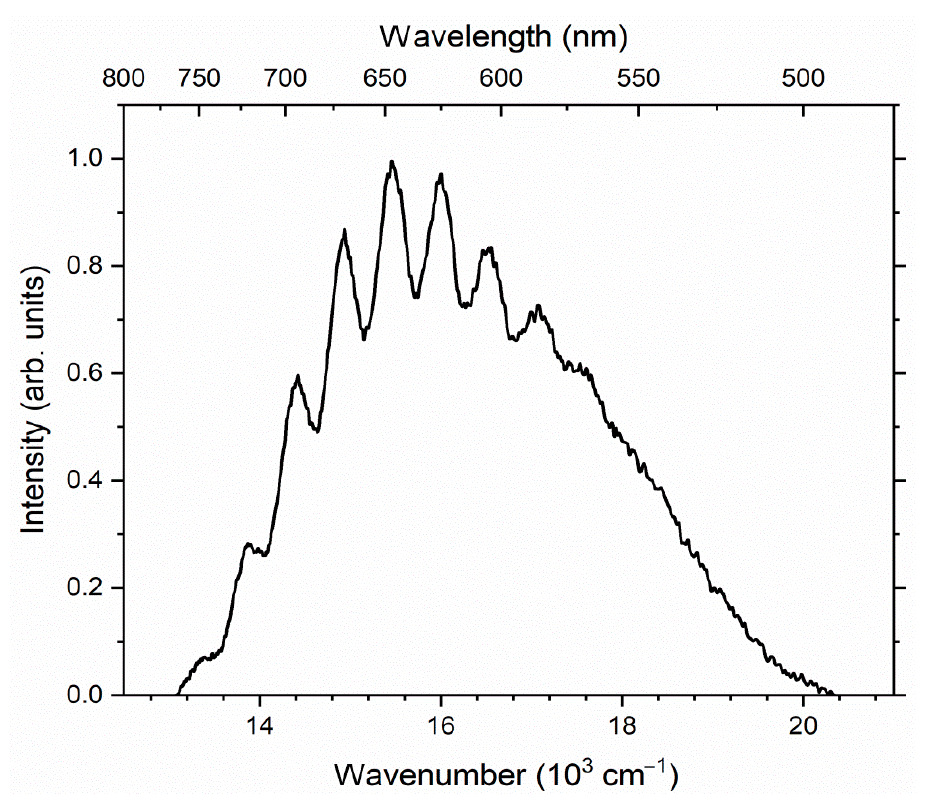
Figure 8. Photoluminescence spectrum of nosean (Sample 7), measured upon excitation with a 405 nm laser at a temperature of 77 K.